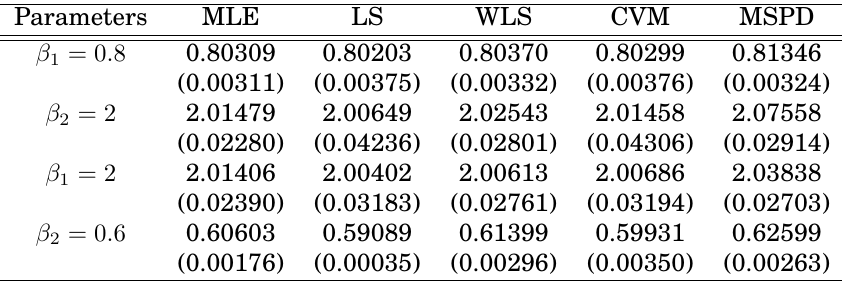
Table 2: AVs and MSEs for ς = 100 .